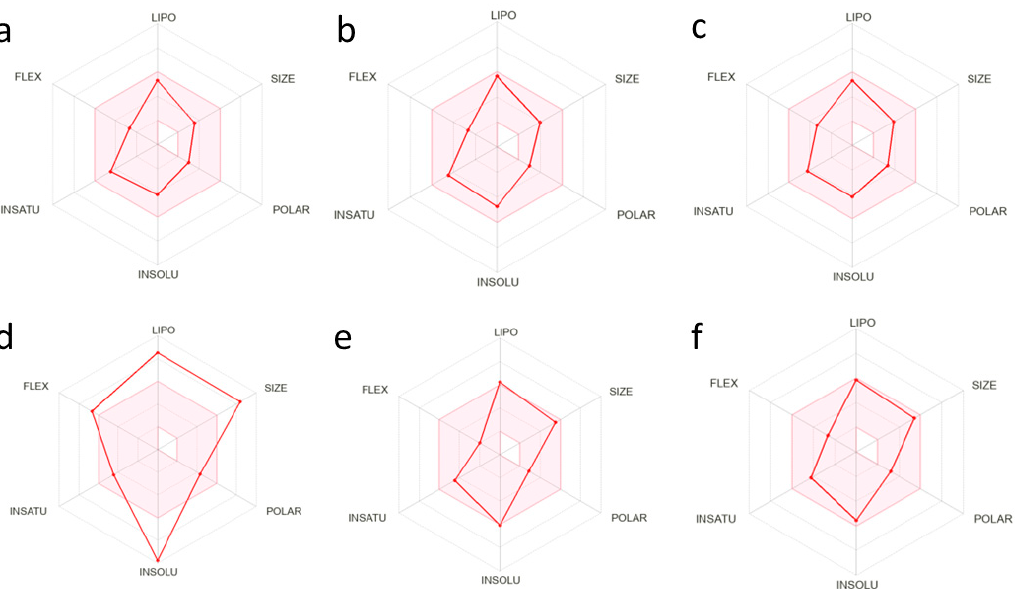
Figure 5. Oral bioavailability graph generated using the SwissADME service: ( a ) L1, ( b ) L2, ( c ) L3,